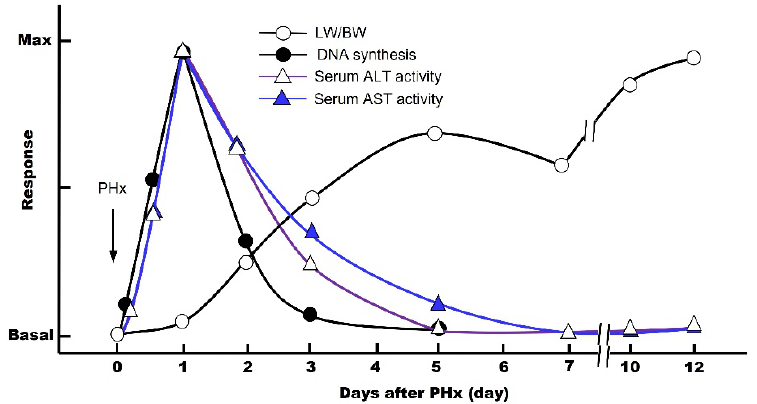
Figure 1. Temporal sequence of events associated with 70% partial hepatectomy (PHx) in vivo. Changes in serum transaminase activity, DNA synthesis activity, and LW/BW ratio.